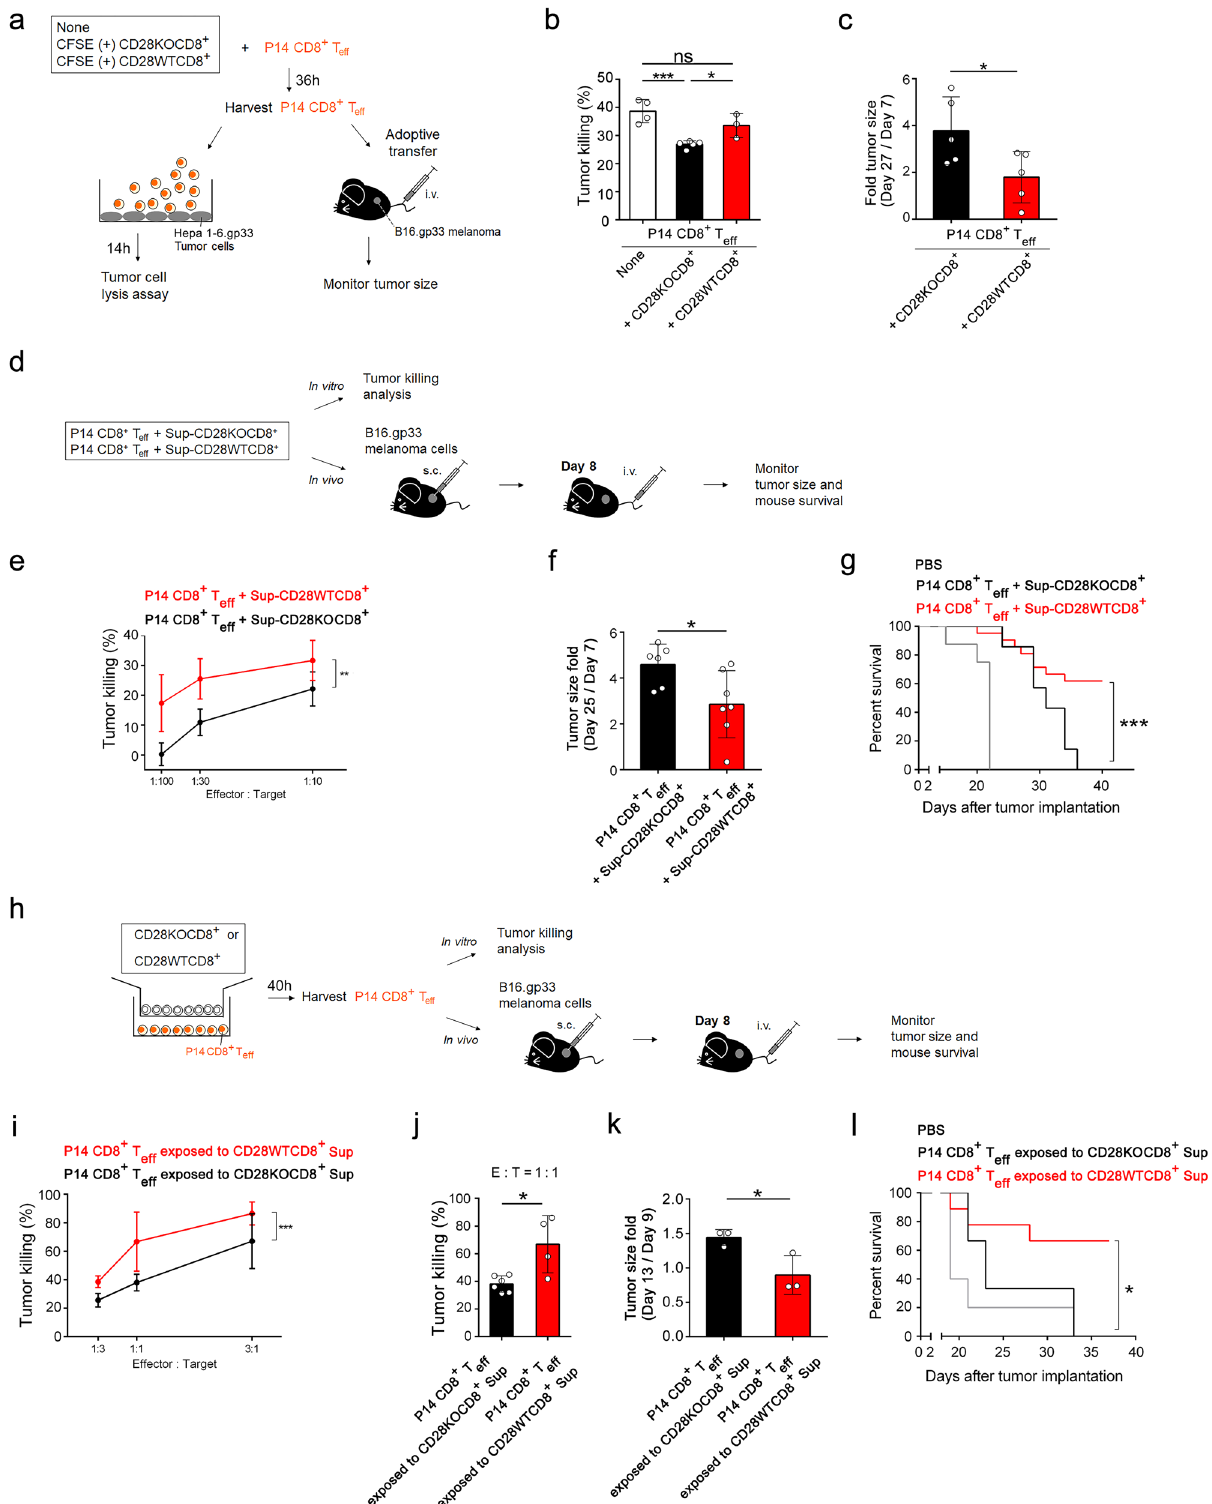
to soluble mediators released by CD28KOCD8 + T cell were less effective than those exposed to that by CD28WTCD8 + in controlling tumor growth (Fig. 1k) and mice receiving P14 CD8 + T eff cells exposed to soluble mediators from CD28KOCD8 + T cells had signi fi cantly poorer survival than those exposed to that from CD28WTCD8 + (Fig. 1l). Taken together, CD28 costimula- tion downregulates the release of soluble factor(s) by